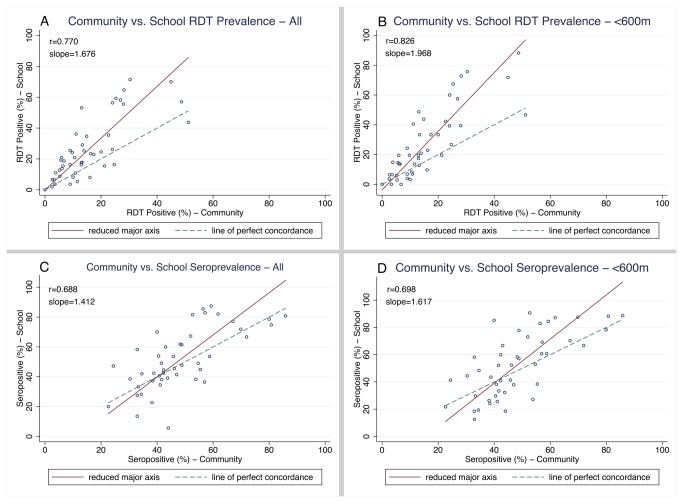
Prevalence of malaria infection in school vs. community surveys in 46 clusters by RDT and serology.Scatter plots are shown with the line of perfect concordance (x=y) and the data’s reduced major axis using total least squares regression. (A) RDT prevalence per cluster in community vs. all school children. (B) RDT prevalence per cluster in community vs. school children residing within 600m from school. (C) Seroprevalence per cluster in community vs. all school children. (D) Seroprevalence per cluster in community vs. school children residing within 600m from school.